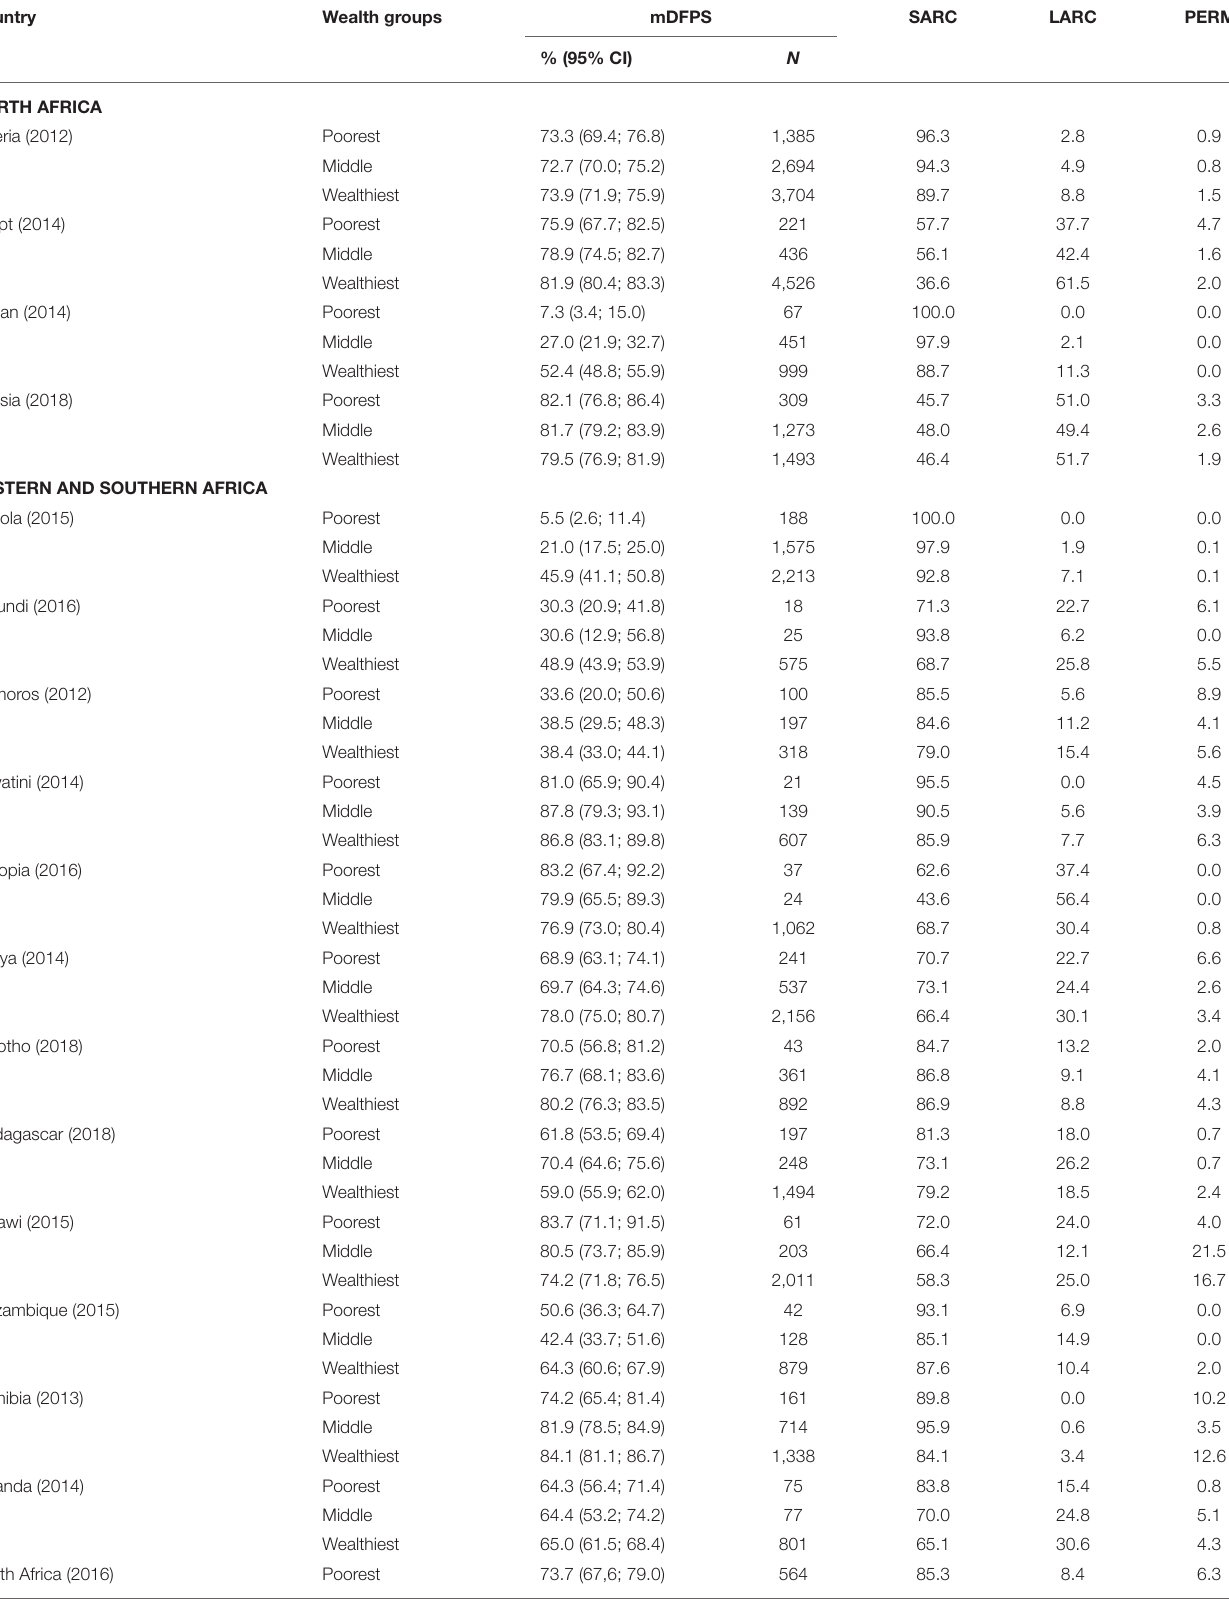
TABLE 2 | Demand for family planning satisfied by modern methods (mDFPS), share of each type of contraceptive method, according to wealth groups. Country Wealth